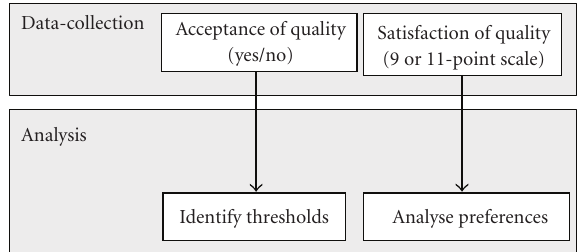
Figure 12: Data-collection and analysis for bidimensional measure combining retrospective overall acceptance and